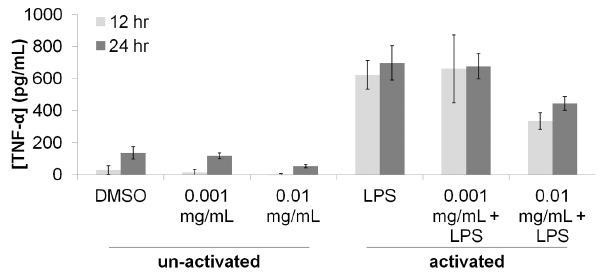
Figure 2. Immunomodulatory activity of T. lanatum extract. The amount of the pro-inflammatory cytokine TNF- α present in the supernatant of macrophage cultures was determined using ELISA at 12 and 24 h after treatments. Cells treated with DMSO (non-activated) were used as negative controls and cells treated with LPS (activated) were used to represent a pro-inflammatory response. Results from an ANOVA test suggest that activation of macrophages significantly alters [TNF- α ] at both the 12-h ( P LPS-12h = 7.40 × 10 − 8 ) and 24-h ( P LPS-24h = 6.57 × 10 − 10 ) time-points. Treatment with 0.01 mg/mL T. lanatum extract significantly altered [TNF- α ] at the 12-h ( P 0.01mg/mL extract-12h = 1.29 × 10 − 2 ) and 24-h ( P 0.01mg/mL extract-24h = 7.67 × 10 − 4 ) time-points. Error bars represent ± one standard deviation from the mean